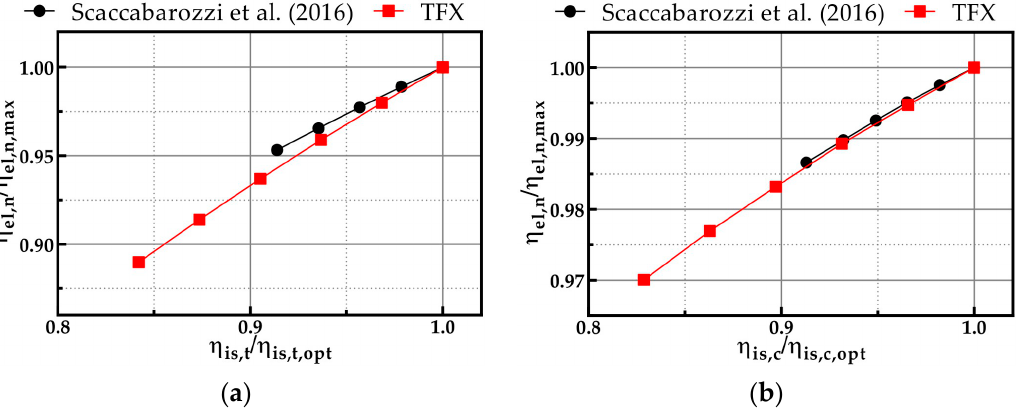
Figure 8. Net electric efficiency of the Allam cycle as a function of turbomachinery efficiency: ( a ) isentropic efficiency of turbine stages; ( b ) isentropic efficiency of CO 2 compressors. Validation against Scaccabarozzi et al., thermodynamic analysis, and numerical optimization of the NET Power oxy-combustion cycle [26].